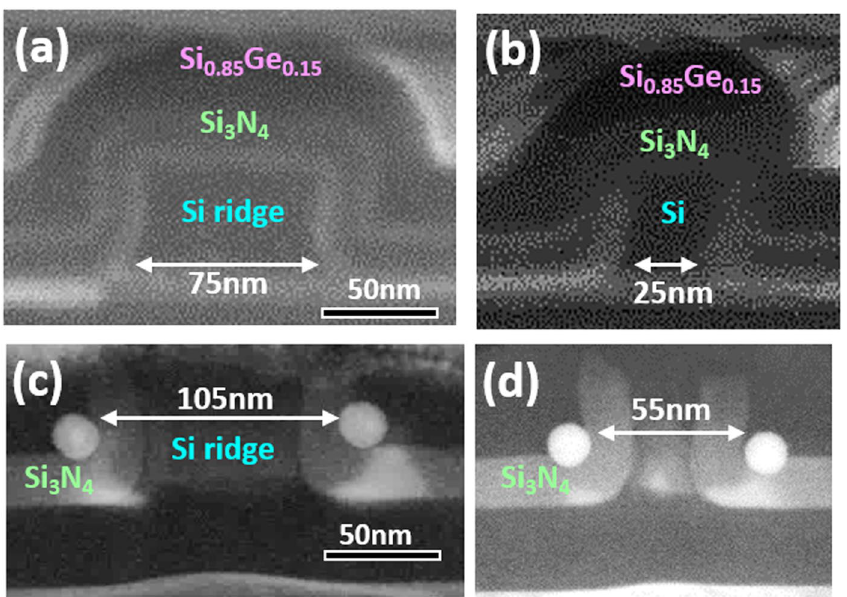
Figure 5. Cross-sectional SEM and TEM micrographs of larger, 20 nm Ge DQDs formed by thermal oxidation at 900 °C for 10.5 min. A decrease in the width of poly-Si ridges from ( a ) 75 nm to ( b ) 25 nm reduces the inter- dot spacing from ( d ) 105 nm to ( e ) 55